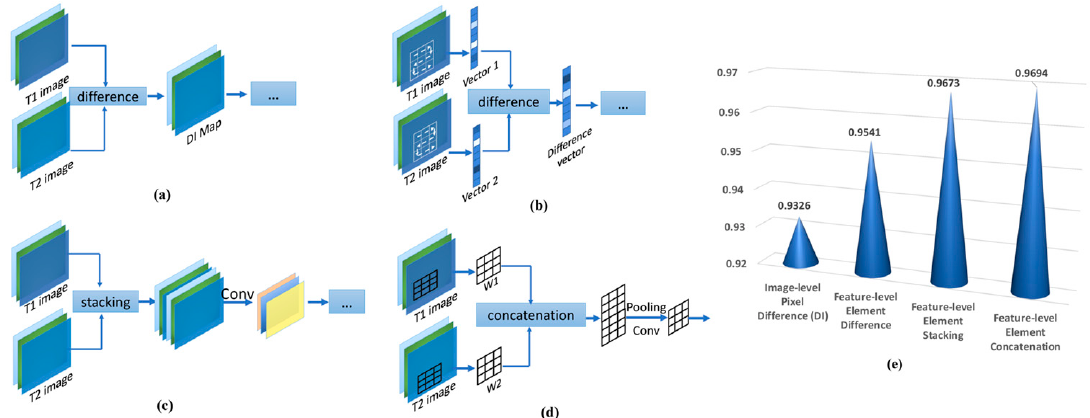
Figure 13. Schematic diagram of various early fusion (EF) structure. ( a ) Image di ff erence structure; ( b ) feature di ff erence structure; ( c ) feature stacking structure; ( d ) feature concatenation structure; ( e ) performance comparison of di ff erent EF methods.